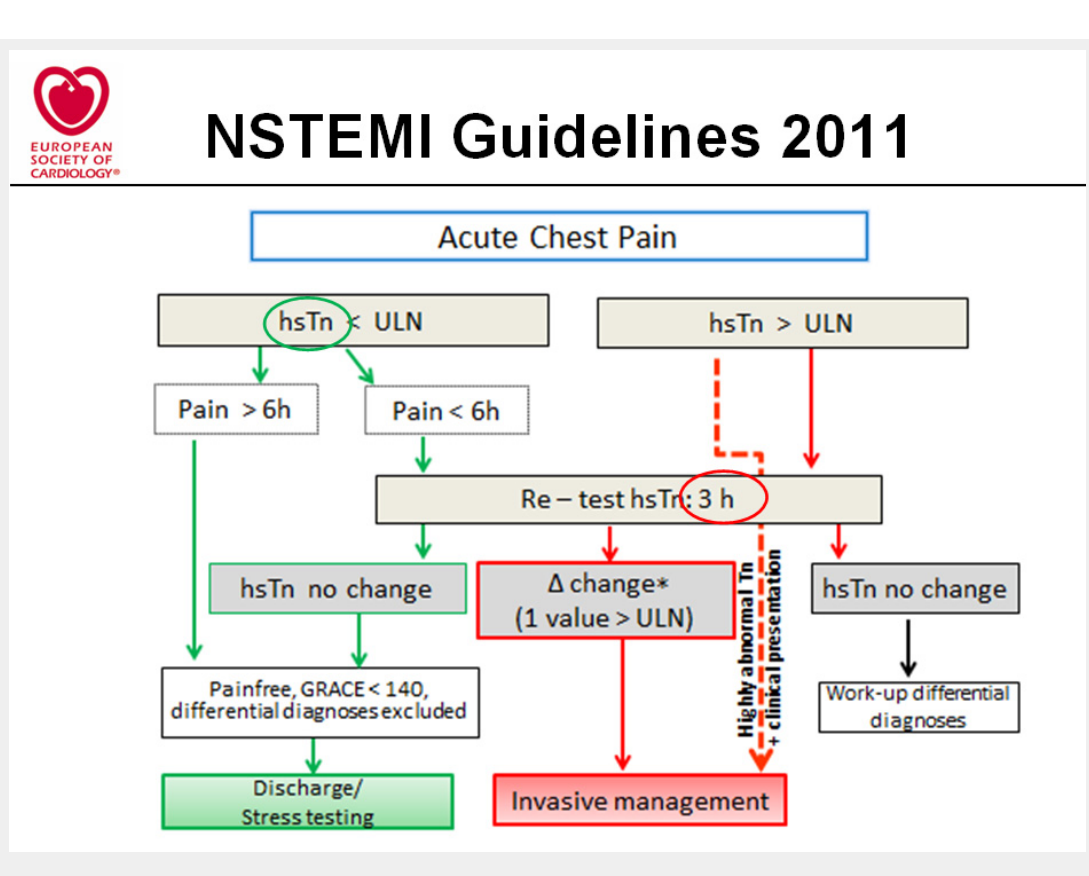
Figure ESC 2011 rapid rule-out algorithm using hs-cTn levels (adapted from ref 1; © reprinted with permission from European Heart